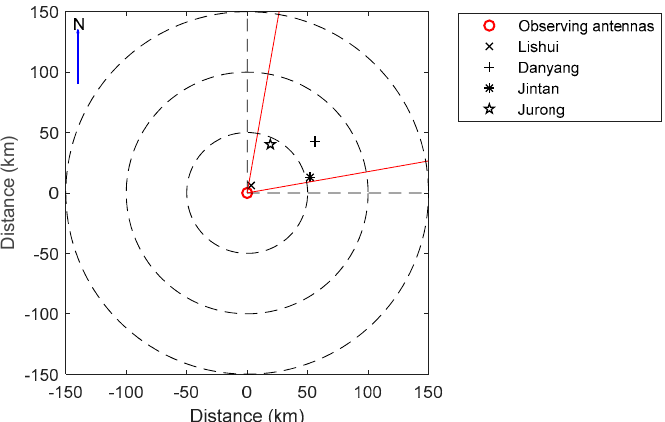
Figure 3. The geographical distribution of the weather stations with respect to the observing antennas and the radar station (same with the observing antenna). The field view of the dual-polarized receiving antenna is between the two red lines in the northeast area. The radar’s detecting distances is shown by the maximum dotted circle.